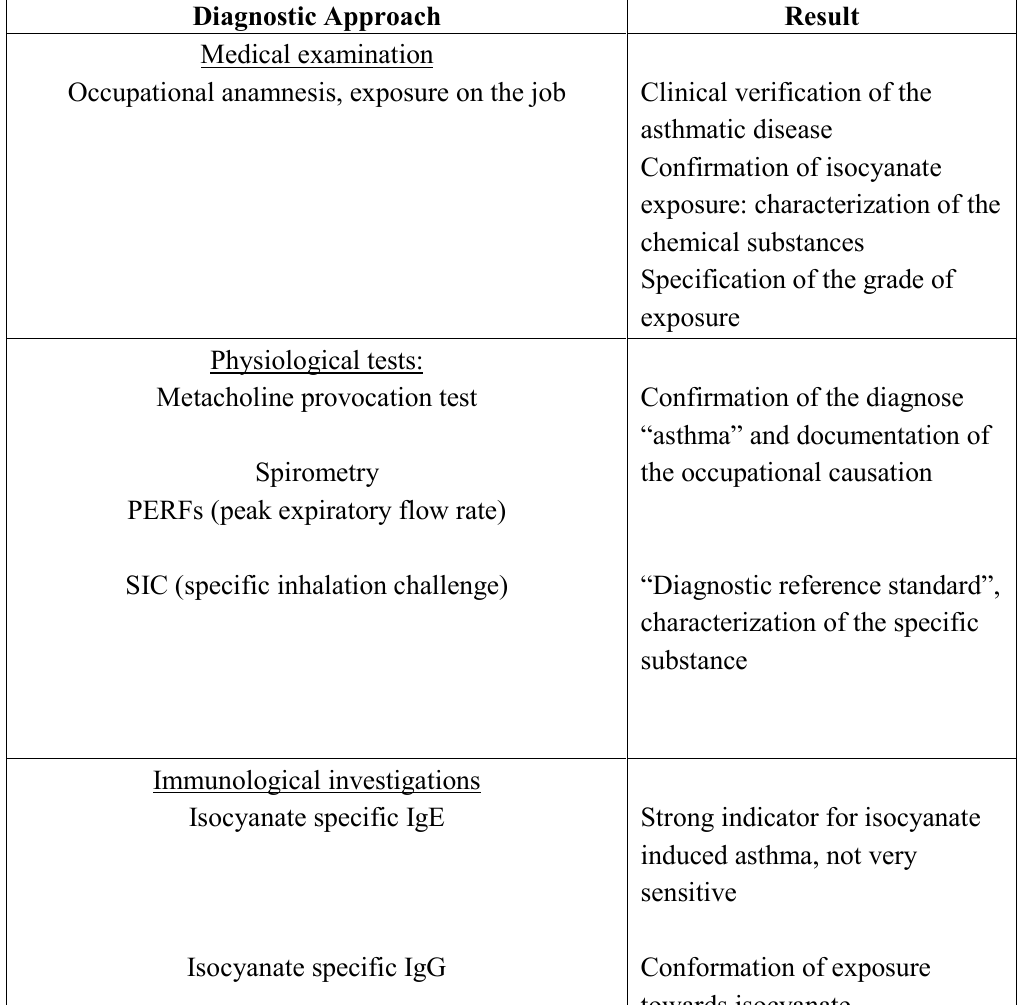
Table 1. Diagnostic tools for the conformation of an occupational isocyanate associated asthma [22],